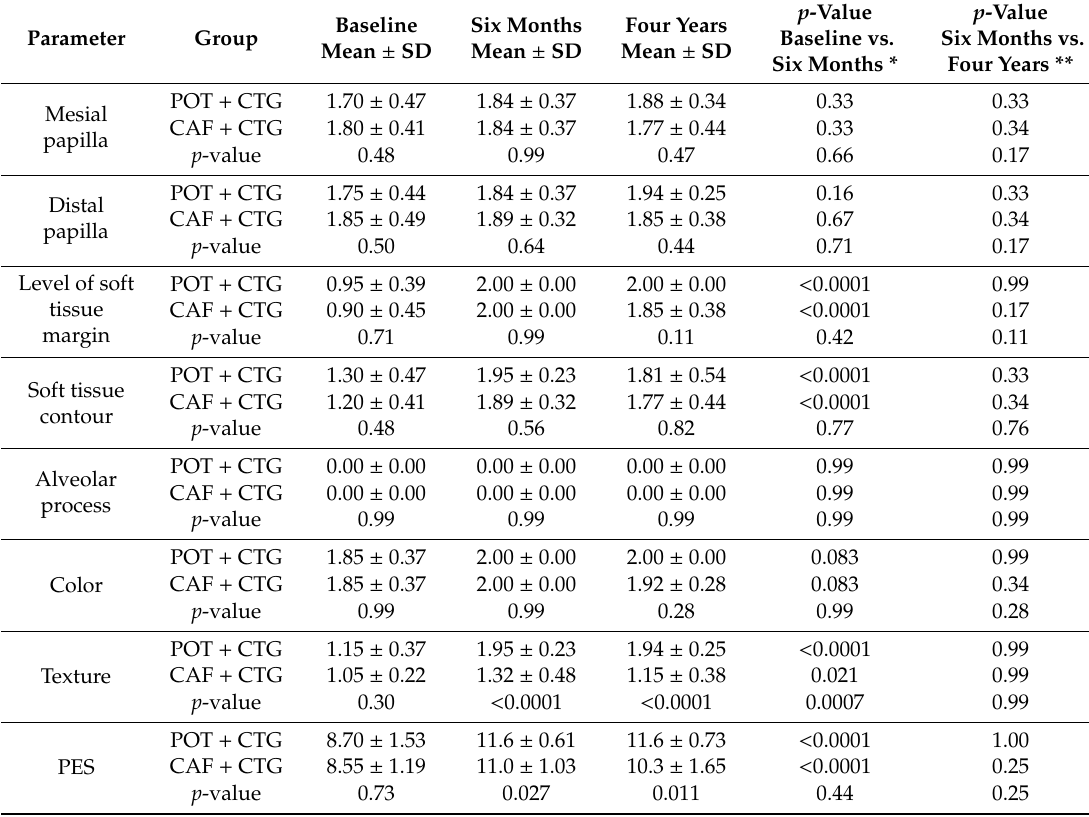
Table 3. Comparative evolution of the esthetic parameters from baseline to four years in the treated (POT + CTG) and control (CAF + CTG)